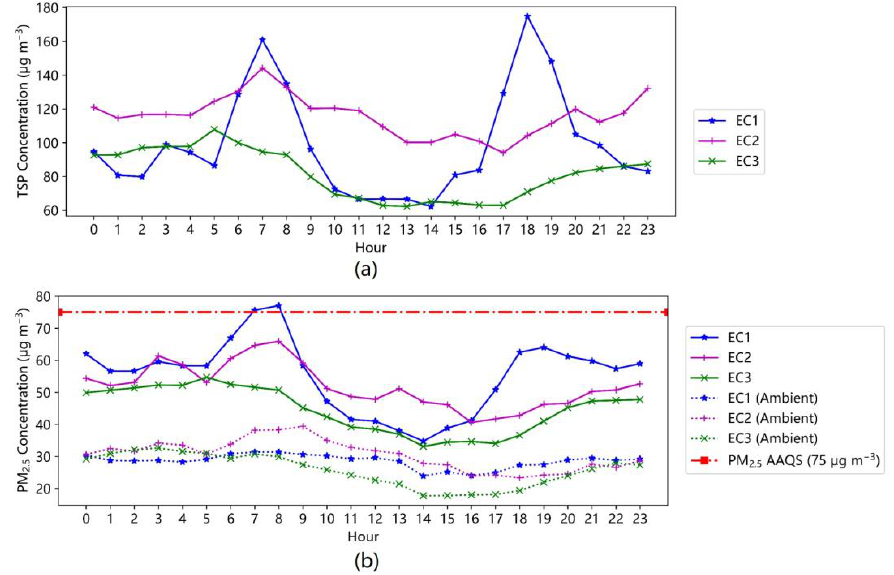
Figure 7. Diurnal variations of indoor TSP ( a ), PM 2.5 and ambient PM 2.5 concentrations ( b ) under three ECs; the red dotted lines in ( b ) representing thresholds of the 24-h average PM 2.5 (50 µ g m − 3 ) concentrations in the air regulated by AAQS of China standard.